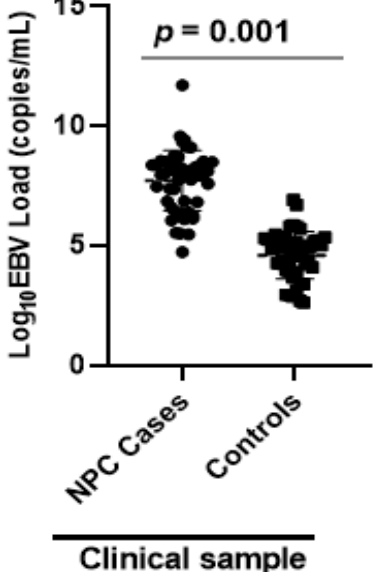
Figure 3. Comparison of EBV load (copies/mL) in whole blood samples of NPC patients and control group. Epstein Barr virus (EBV) load quantification in whole blood samples was done by EBNA-1 real-time PCR in nasopharyngeal cancer (NPC) patients and healthy controls. EBV copies are represented on logarithmic scale (Log 10 ). Comparison of the median EBV load between cases ( n = 37) and controls ( n = 48) was performed using a Mann–Whitney test. EBV load was significantly higher in NPC patients than controls ( p = 0.001).